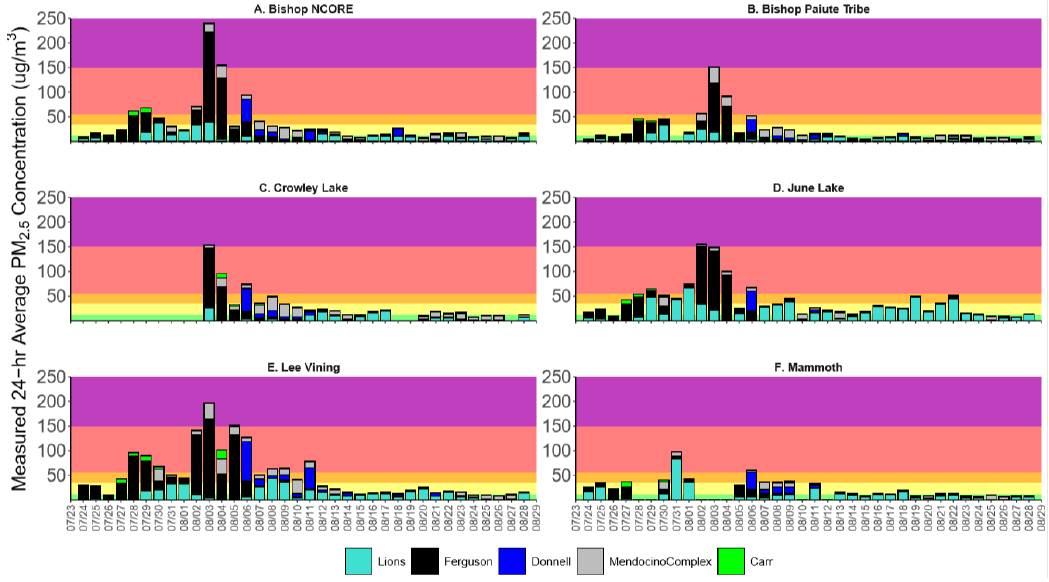
Figure 4. Apportionment of measured 24 h average PM 2.5 concentration, 23 July–29 August 2018 by fire (Lions, Ferguson, Donnell, Mendocino Complex, Carr) at each of the six monitoring sites (Bishop NCORE, Bishop Paiute Tribe, Crowley Lake, June Lake, Lee Vining, Mammoth). Background color indicates U.S. Environmental Protection Agency (EPA) Air Quality Index (AQI) category; Green: Good, Yellow: Moderate, Orange: Unhealthy for Sensitive Groups, Red: Unhealthy, and Purple: Very Unhealthy. Table 1. Comparisons of modeled smoke apportionment and impacts per air quality monitoring site and per fire. Individual data points are rounded to the nearest whole number.